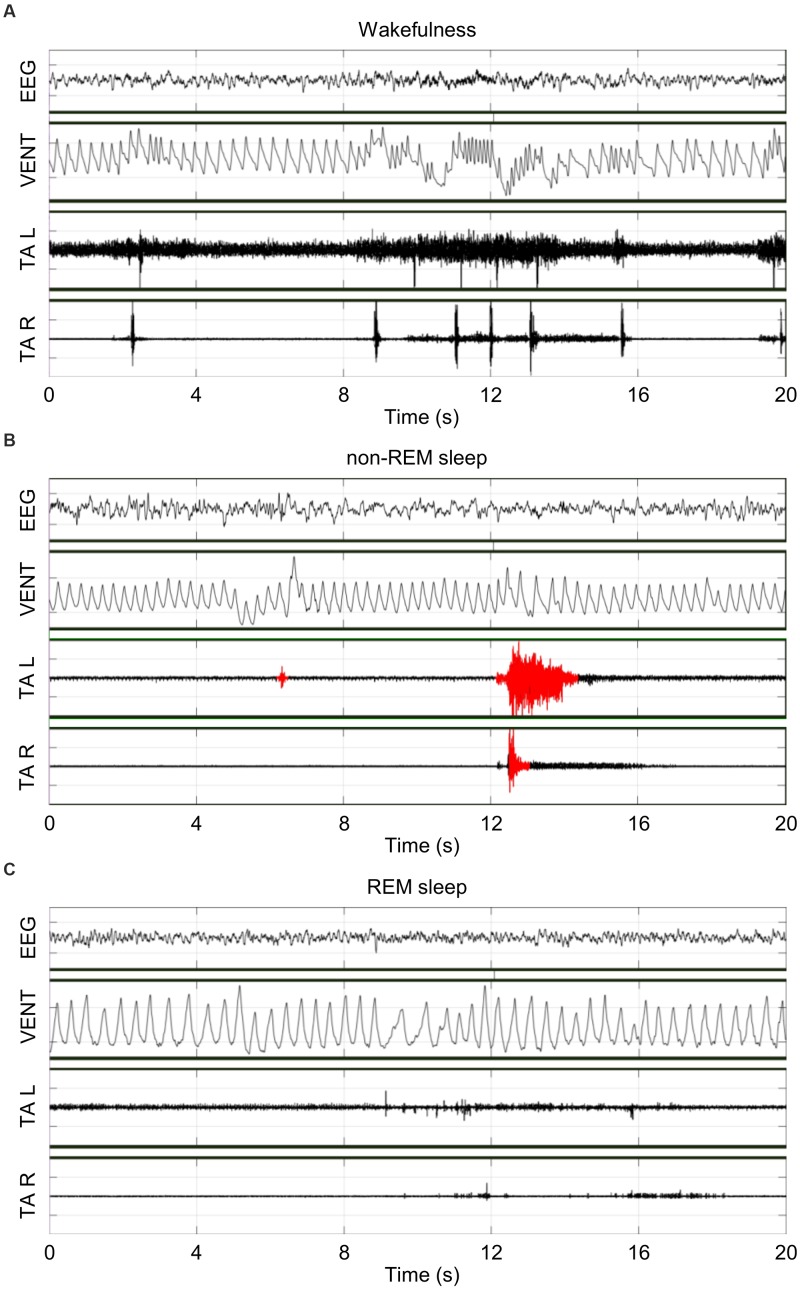
Representative raw tracings of the electroencephalogram (EEG), the raw ventilation signal yielded by the whole-body plethysmograph (VENT), and the left (L) and right (R) electromyogram (EMG) of tibialis anterior (TA) muscles during wakefulness (A), non-rapid-eye-movement (non-REM) sleep (B), and rapid-eye-movement (REM) sleep (C) in the same iron-deficient mouse in conditions of hypoxia. Scoring of TA EMG bursts (red) was performed only in non-REM sleep.